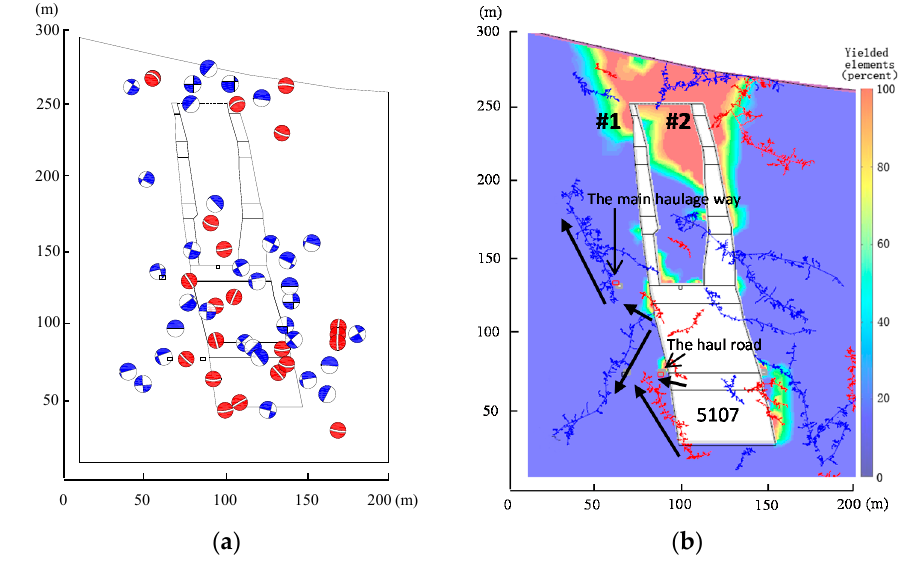
Figure 12. The crack evolution mechanism in the roadway failure process: ( a ) the rock mass failure mode; ( b ) the crack evolution mechanism. The red moment tensor balls and red cracks represent tension failures, and the blue moment tensor balls and blue cracks represent shear failures.